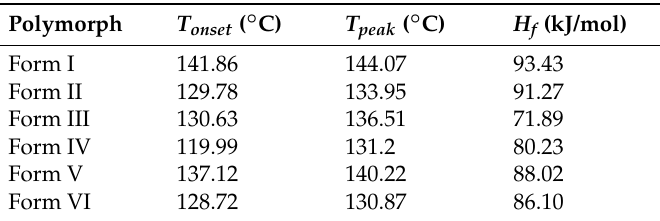
Figure 5. DSC curves of famoxadone from Form I to Form VI. Table 2. Melting data of famoxadone polymorphs.